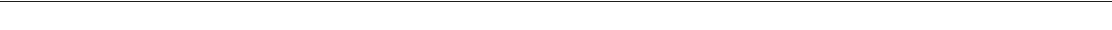
Fig. 4 ATRA reverses the PGD2-ILC2-IL-13-M-MDSC immunosuppressive axis. a Schematic representation of the hypothetical immunosuppressive chain established in APL patients at diagnosis. b Comparison of serum concentrations of PGD2 (APL = 11; Rem = 9), c frequencies of ILC2 NKp30 + (APL = 11, APL Rem = 9), d frequencies of total ILC2 (APL = 22; APL Rem n = 9), e serum concentrations of IL-13 (APL n = 11; APL Rem n = 9) and f frequencies of M-MDSC (APL n = 22; APL Rem = 9) in peripheral blood of APL patients at diagnosis (APL) or in remission after ATRA treatment (APL Rem). Dashed lin es represent mean values of all the parameters in HD. g Schematic representation of APL establishment and ATRA treatment schedule in FVB/NJ mice upon injection of APL splenocytes (three independent experiments), as assessed by quanti fi cation of the normal composition of the bone marrow (Gr1 + CD11b + cells) h , as previously described 27 . i Survival curves of untreated (APL, n = 13) and ATRA-treated (ATRA) APL mice ( n = 6). j Quanti fi cation of PGD2 concentrations (CTR n = 15, APL n = 13, ATRA day 14 n = 9, ATRA day 25 n = 6), k ILC2 frequencies and l M-MDSCs frequencies in control FVB/NJ mice (CTR), APL mice before (APL) and after ATRA treatment (ATRA day14; ATRA day25) (CTR n = 12, APL n = 10, ATRA day 14 n = 9, ATRA day 25 n = 6). m Schematic representation of APL establishment and ATRA treatment schedule in HIS mice upon injection of an APL cell line (two independent experiments). n Survival curves of untreated (APL, n = 5) and ATRA-treated (ATRA, n = 3) APL HIS mice. o Quanti fi cation of PGD2 concentrations (CTR n = 8, APL n = 8, ATRA n = 5), p ILC2 frequencies (CTR n = 11, APL n = 13, ATRA n = 9) and q M-MDSCs frequencies (CTR n = 8, APL n = 8, ATRA n = 5) in APL HIS mice before (APL) and after ATRA treatment at day 25 (ATRA) (up to two independent experiments). Error bars are s.e.m. Statistical analysis was performed using Mann-Whitney test ( b – f ), Kruskal-Wallis test ( h , j – l , o – q ) and Log-rank test (Mantel-Cox) ( i , n